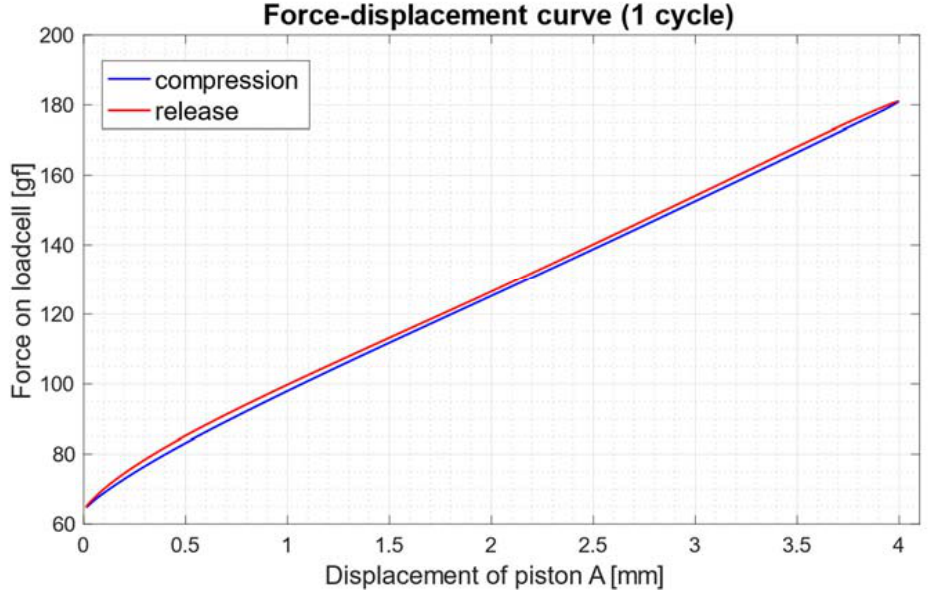
Figure 11. Force—displacement relationship for one stress cycle at 0.80 Hz (motor power supply set to 8 V): force on loadcell vs. displacement of piston A. The hysteresis is graphically represented by the area between the curves depicted in red and blue.